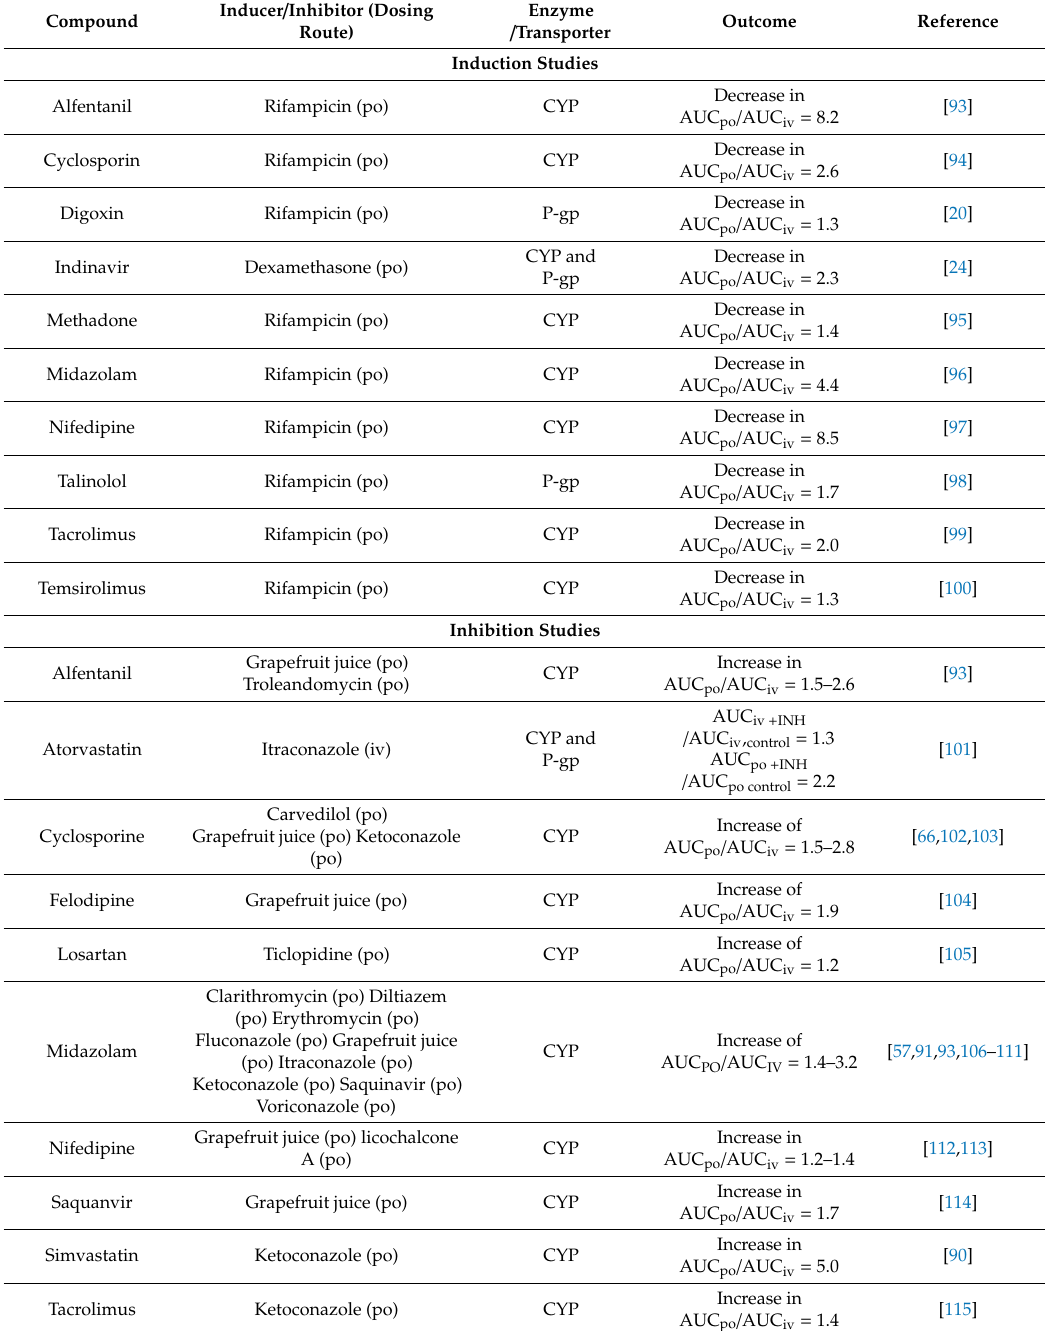
Table 3. Greater inhibitory or inductive e ff ects after oral administration than iv administration for drug–drug interactions (DDIs) of the